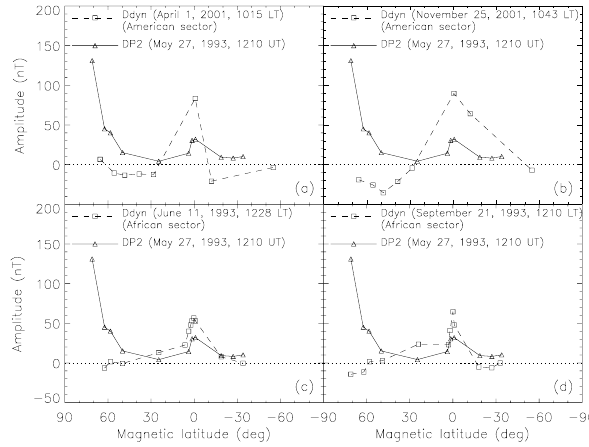
Fig. 12. Latitudinal profiles of the magnetic disturbance Ddyn com- pared with the latitudinal profile of the DP2 disturbance on 27 May 1993 at